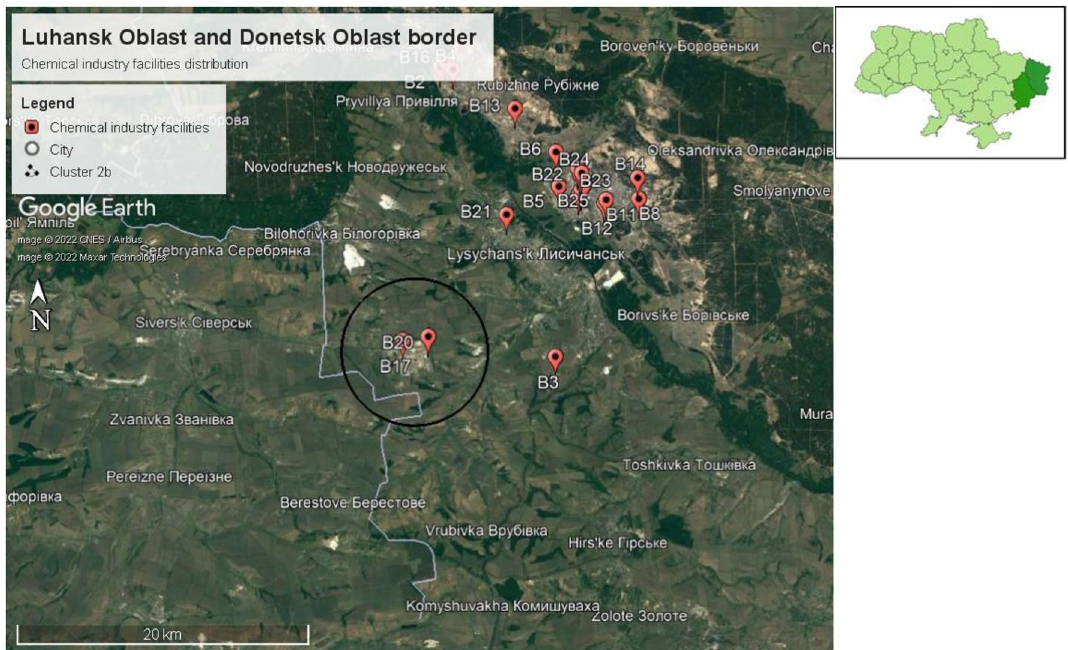
Figure 15. Chemical plant cluster 2b located near the border of Donetsk